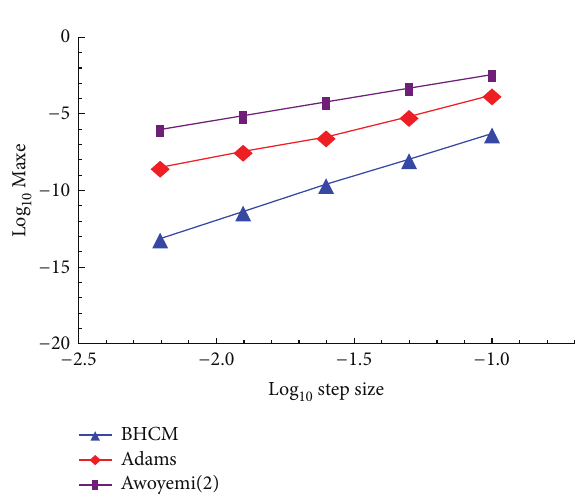
Figure 1: Performance comparison for Problem 1 when 𝑏 = 1 .